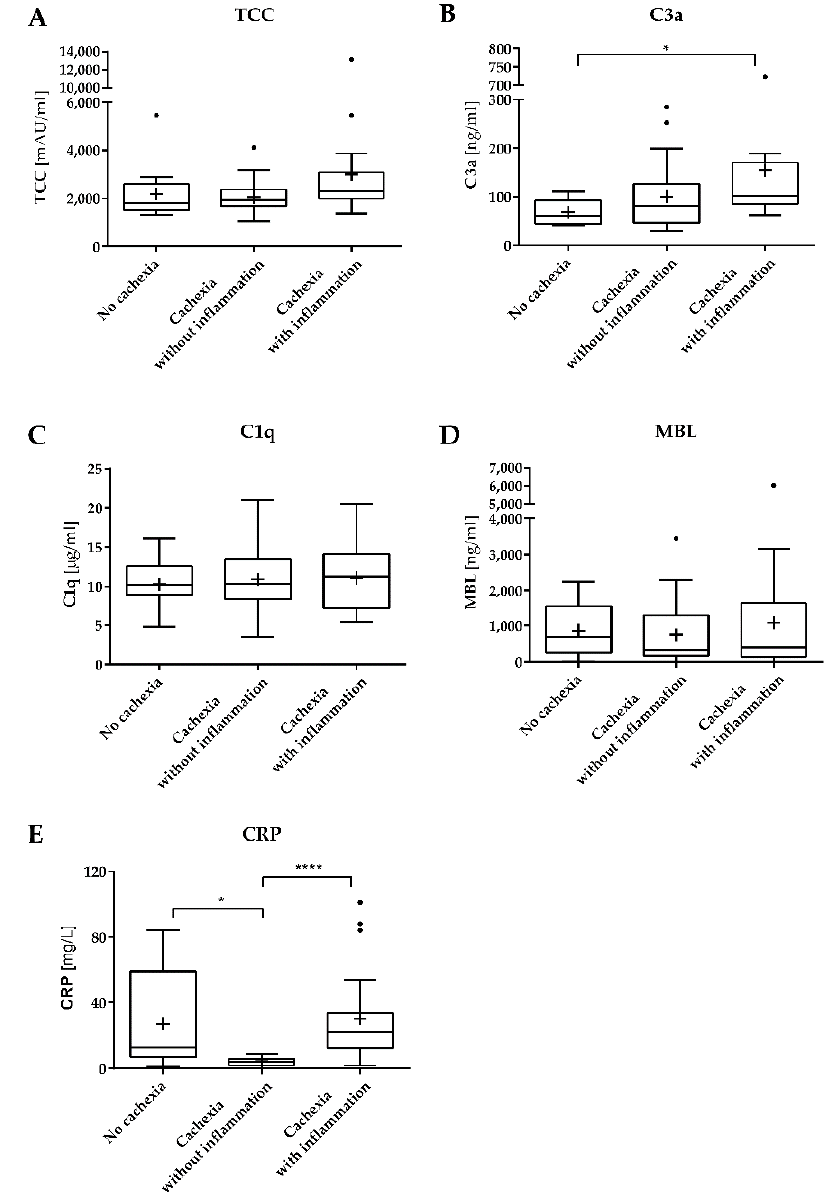
Figure 1. Plasma concentrations of C3a, TCC, C1q, MBL, and CRP in patients with pancreatic cancer. Tukey box-and-whisker plots are displayed, showing significantly elevated C3a concentrations in the blood of patients with cachexia and inflammation (panel A , p = 0.0186). TCC concentrations are higher in this group as well, with a trend towards significance (panel B , p = 0.0511). C1q (panel C ) and MBL (panel D ) concentrations do not differ between the groups. CRP concentrations were lower in cachectic patients without inflammation as compared to cachectic patients with inflammation or patients without cachexia (panel E , p < 0.0001, p = 0.0137, respectively). The line reflects the median; the hinges of the boxes are drawn at the 25th and 75th percentile. The dots reflect the outliers as defined by the Tukey method. The mean concentrations are indicated by the ‘plus’ sign. * p ≤ 0.05; **** p ≤ 0.0001.